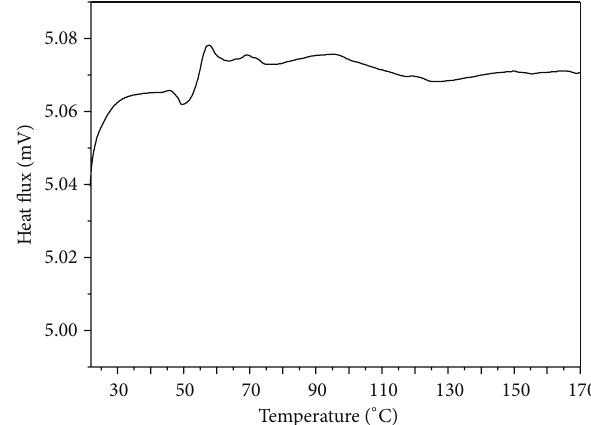
Figure 2: DSC curve of PDLLA synthesized, heated from 20 to 170 ∘ C at 2 ∘ Cmin −1